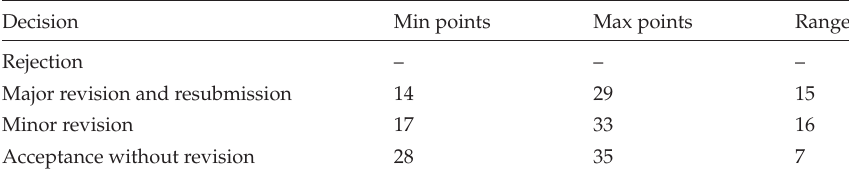
Table 21: Overlapping points and decisions for PR4